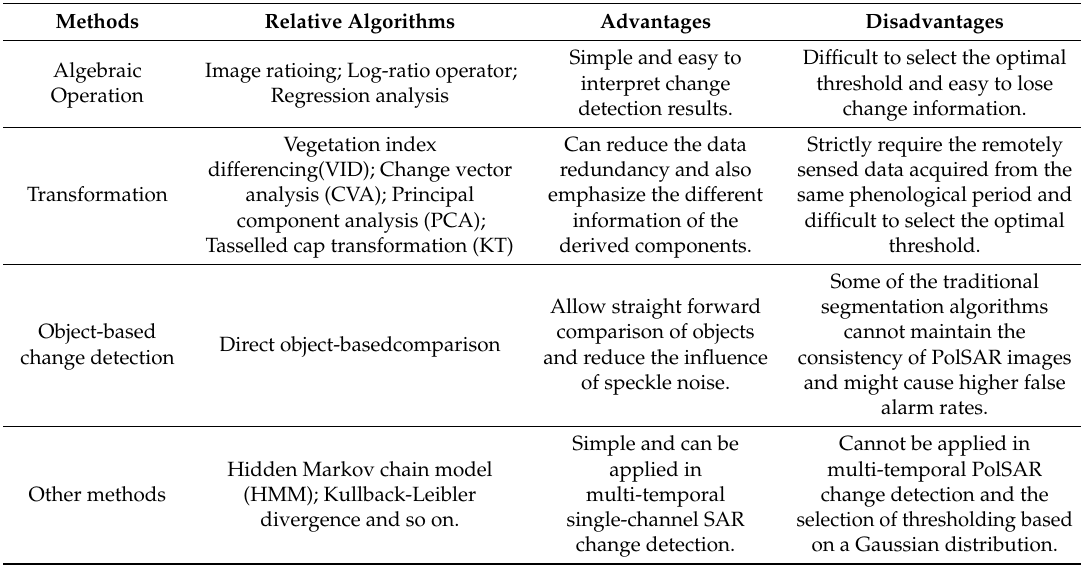
Table 1. A summary of the traditional unsupervised change detection